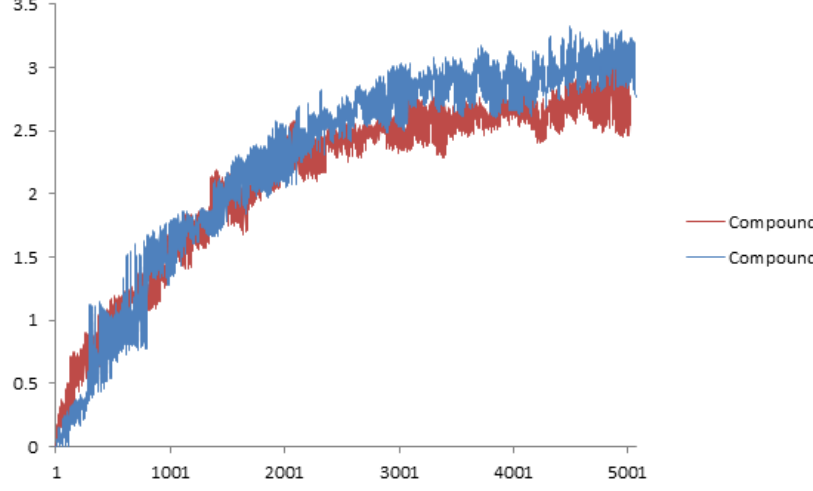
Figure 6. RMSD tendency of the ligand-receptor complex at different MD simulation times, red and blue curves indicate the compounds 04-3zim and 72-3zim complexes, respectively.